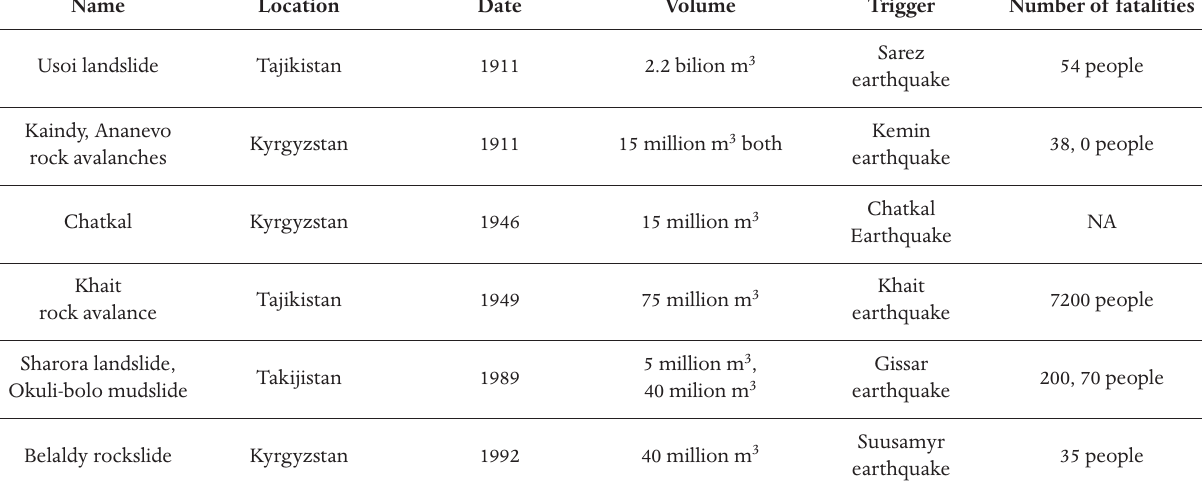
Table 1. List of the largest historical earthquake-induced landslides in Central Asia.